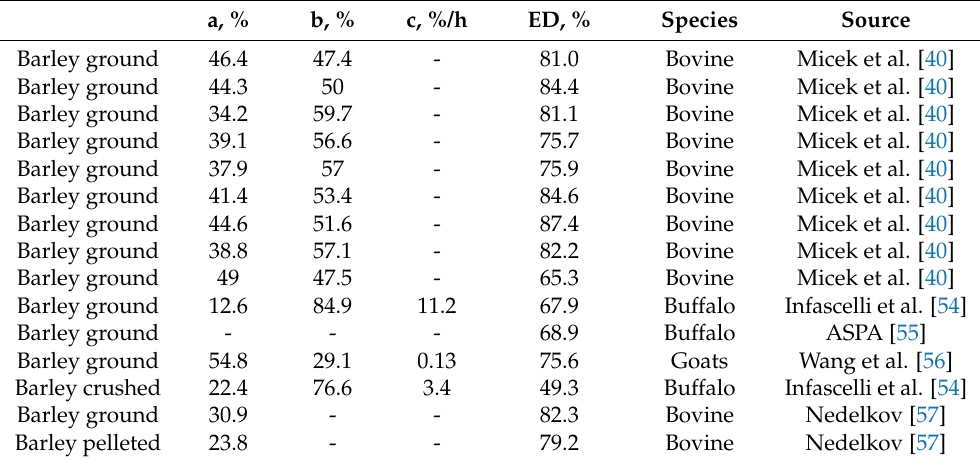
Table 2. Protein degradability of raw and treated barley